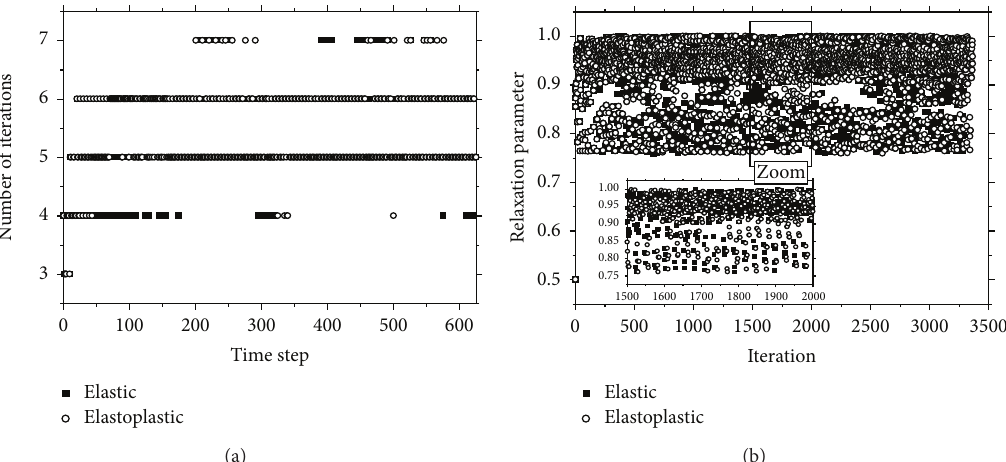
Figure 13: TD-BEM/FEM analyses: (a) number of iterations per time step considering optimal relaxation parameters; (b) optimal relaxation parameters for each iterative step.